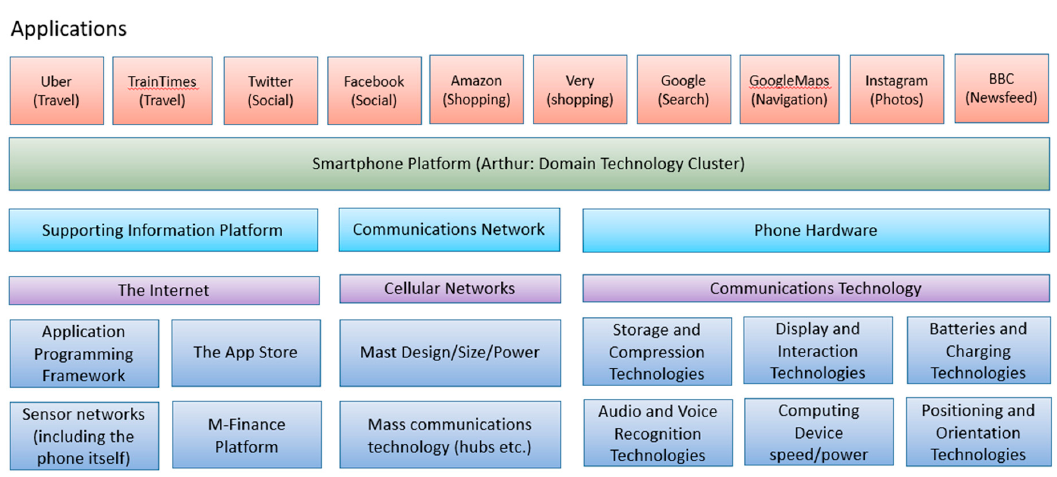
Figure 9. Technologies supporting the smartphone platform.